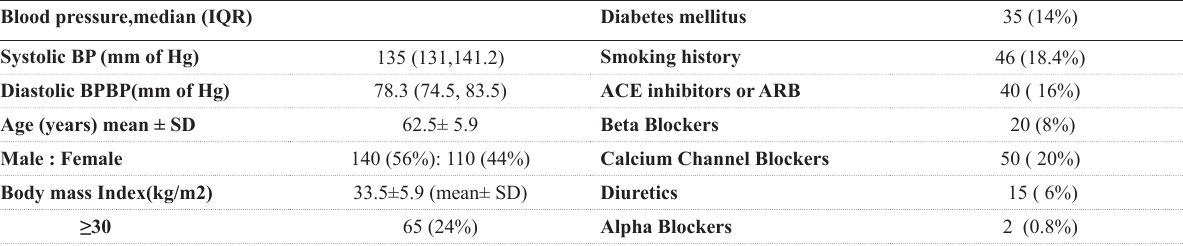
Table 1 Characteristics of patients with uncontrolled hypertension